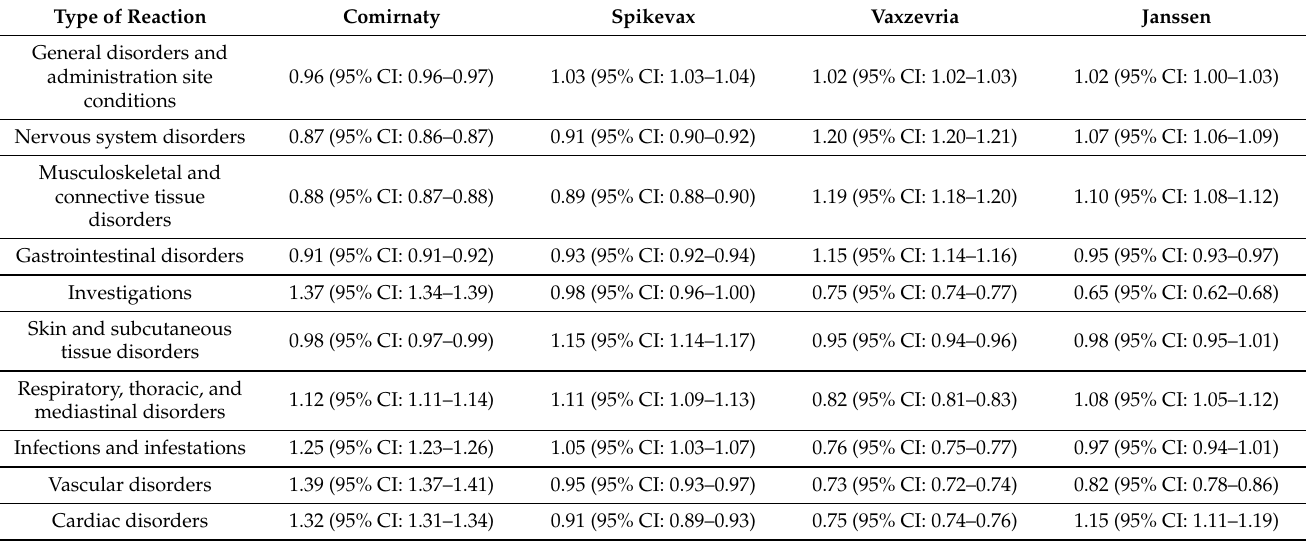
Table 9. Calculation of PRRs of the main adverse events reported in EudraVigilance for each COVID- 19